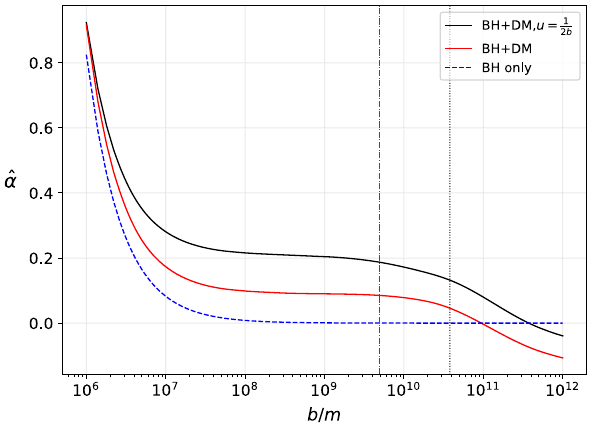
Fig. 6 CurveoftheweakdeflectionangleintheURCprofilefordiffer- ent values of impact parameter b / m in Sgr. A*. The vertical dotted line is the value of the outermost core radius r c ∼ 3 . 79 × 10 10 m . The region below the dash-dotted vertical line is the cusp region ( ∼ 4 . 859 × 10 9 m